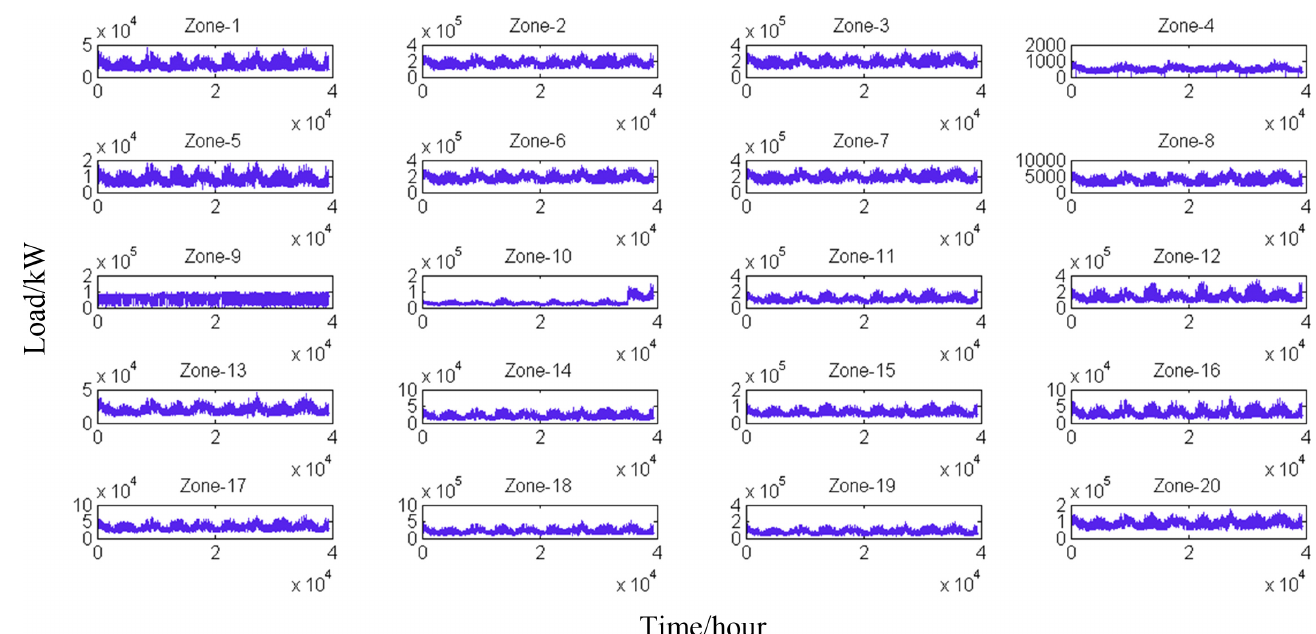
Fig 1. Historical loads in the 20 zones. The loads in the majority of the zones are approximately measured at the 100,000 kW level; however, some zones have loads near the 10,000 kW level, such as Zone 1, Zone 13 and Zone 14. Zone 4 has the lowest load of less than 1,000 kW. Large differences in the load fluctuations of these 20 zones are